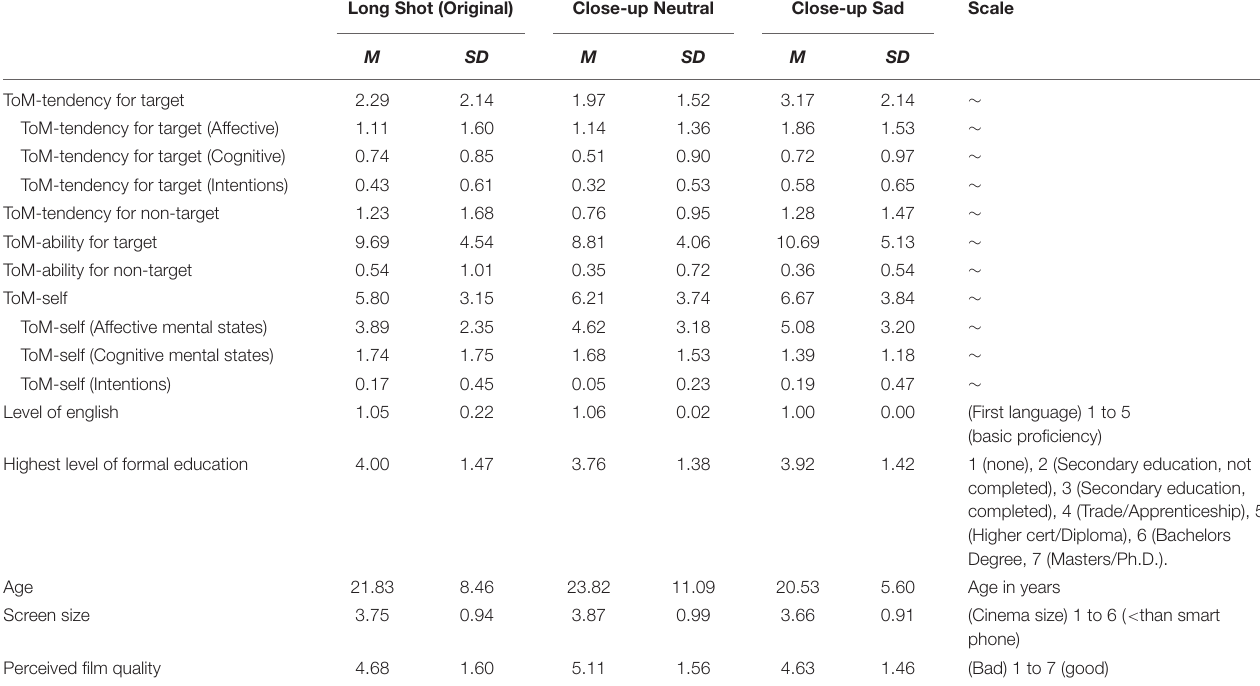
TABLE 3 | Means and standard deviations for output and other